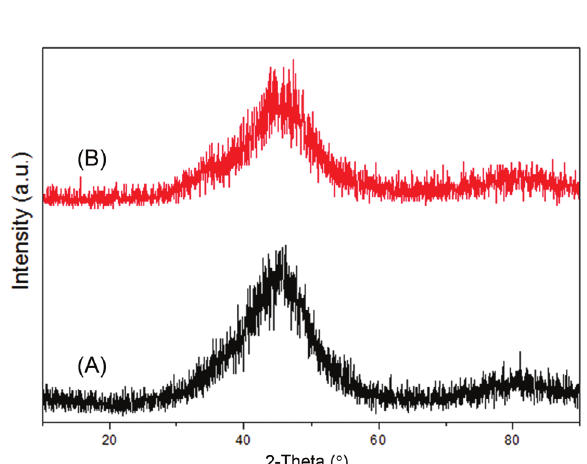
Figure 3: SEM images of Ni-B amorphous particles synthesized in microfluidic reactor at the flow rate of 15 mL/min (A and A ’ ) and 25 mL/min (B and B ’